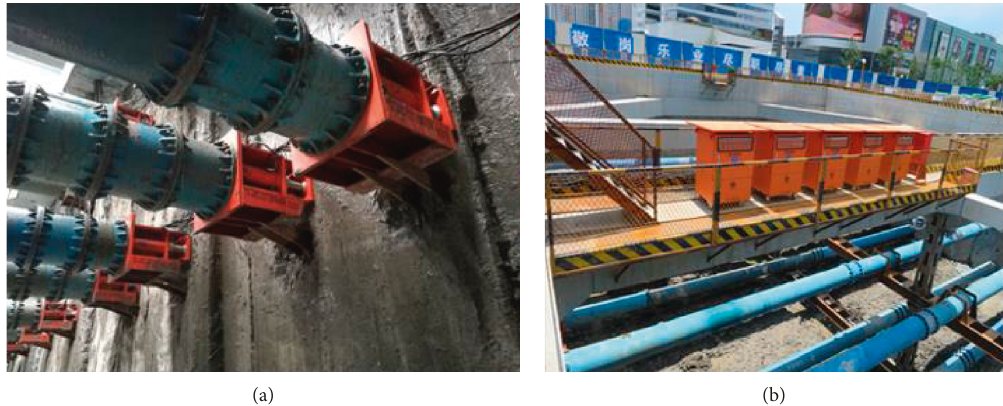
Figure 5: Installed hydraulic servo steel strut system: (a) hydraulic servo struts; (b) control system.